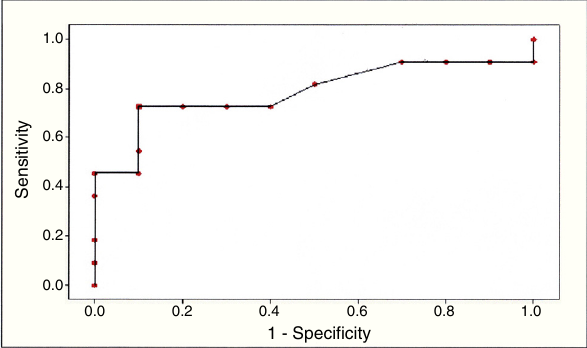
Figure 2 Receiver operating characteristic (ROC) curve for